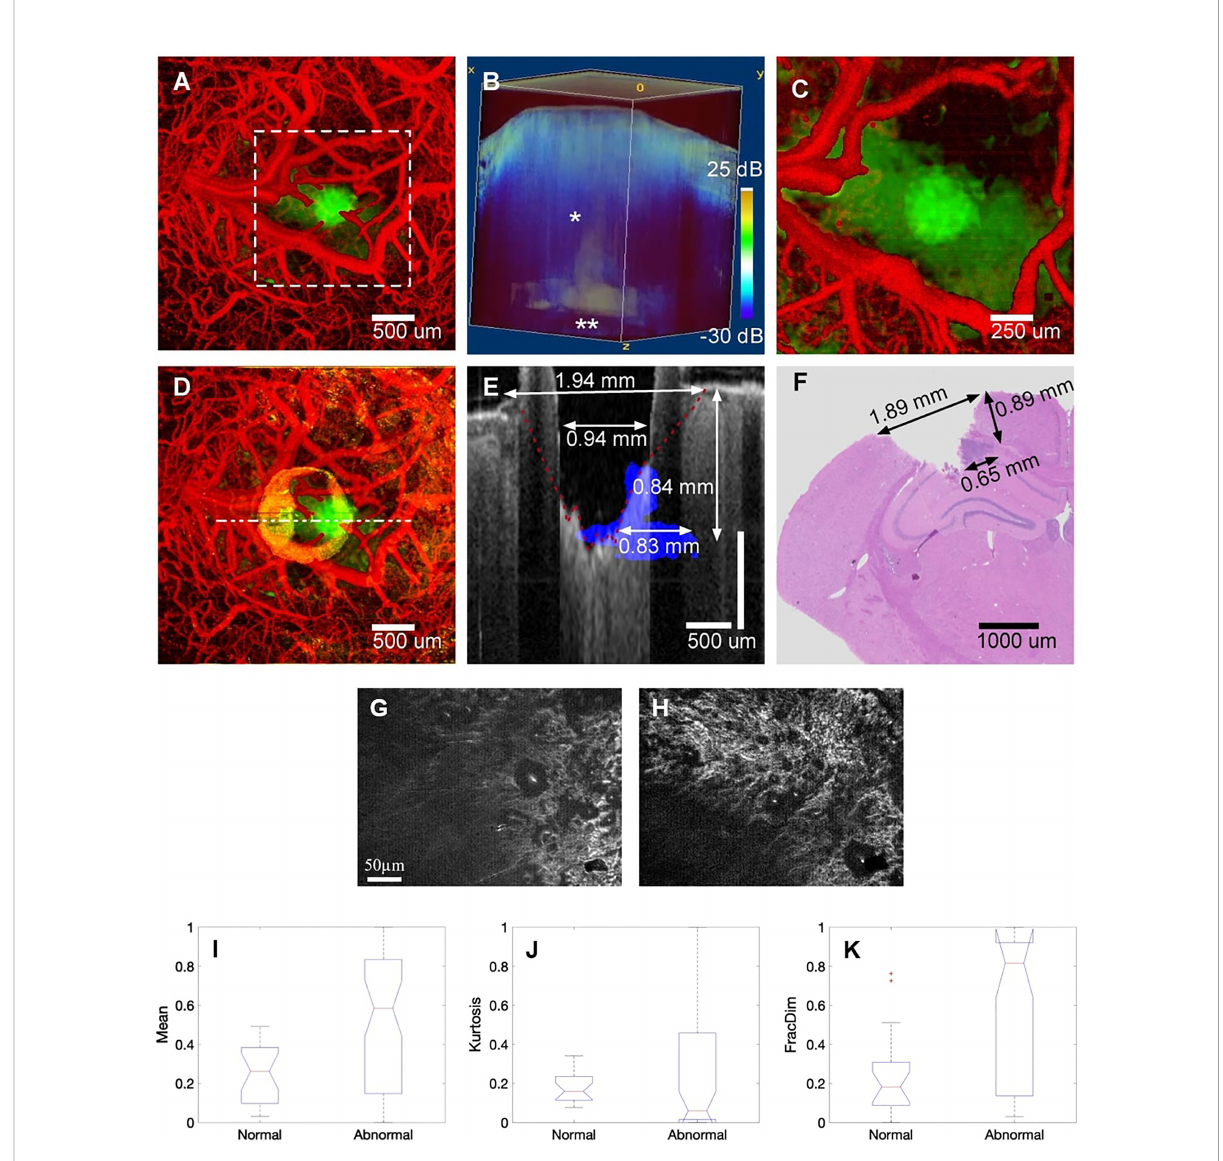
FIGURE 6 (A) Pretreatment of cerebral surface vascular construction (red) and tumor area (green) in mice. (B) Renders an image in 3D with an attenuation rate threshold mask superimposed on the OCT intensity (blue). (C) Maximum intensity projection after coagulation. (D) Maximum intensity projection after ablation. (E) After overlapping the tumor margins (blue) before ablation, stain the corresponding area with the post-ablation b- scan (gray) (F) H&E stained of the corresponding region (72); Copyright 2019, Theranostics. (G) FF-OCT image of normal and (H) cancerous hepatic cell. (I-K) Boxplot of selected features for the Mean, Kurtosis, and FracDim. the mean and kurtosis are not sensitive in distinguishing between normal and cancerous hepatocytes, when the liver becomes cancerous, the value of the fractal parameter increases (88). Copyright 2020,